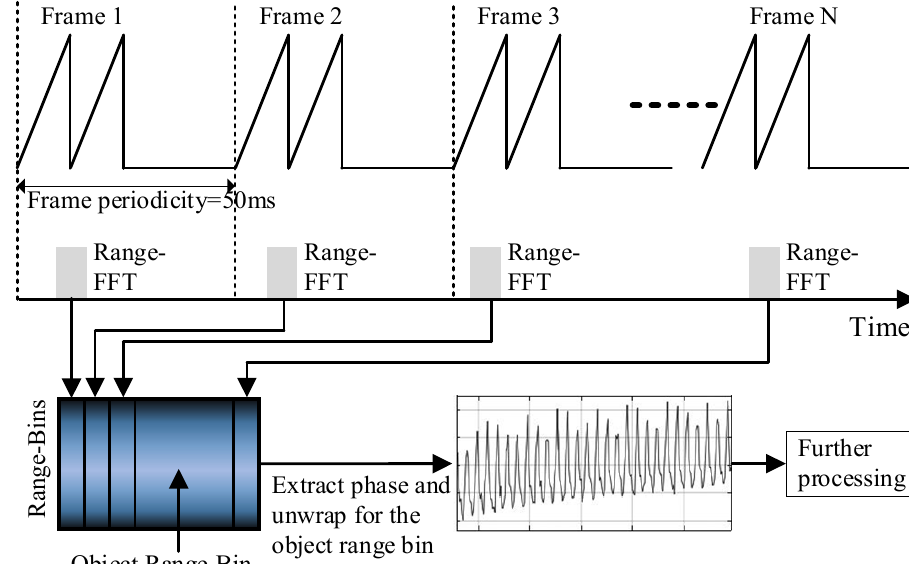
Figure 10. Emission waveform diagram [9–11].